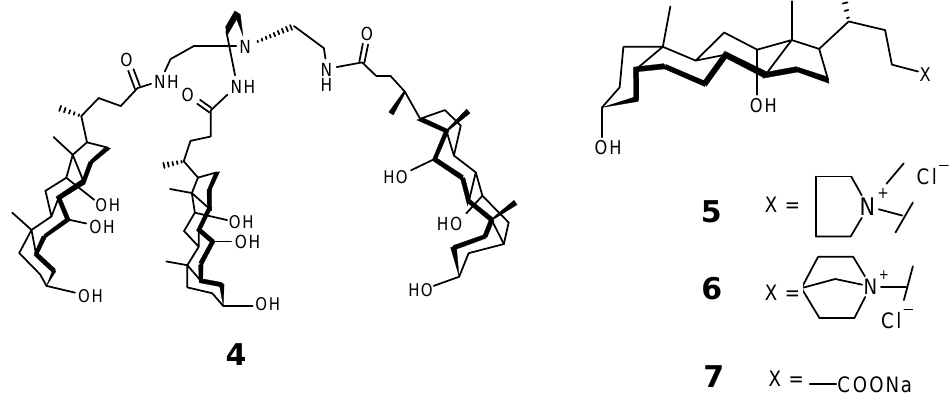
Figure 2 : Structure of the gelators used for making the gels to carry out